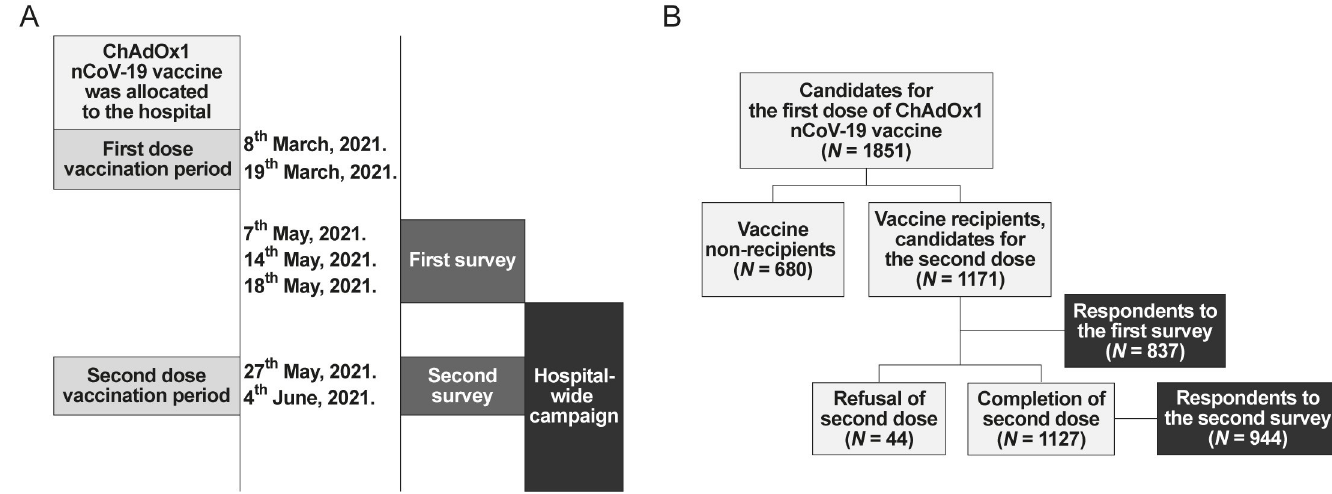
Fig 1. Timeline of vaccination, survey, and the hospital-wide campaign.